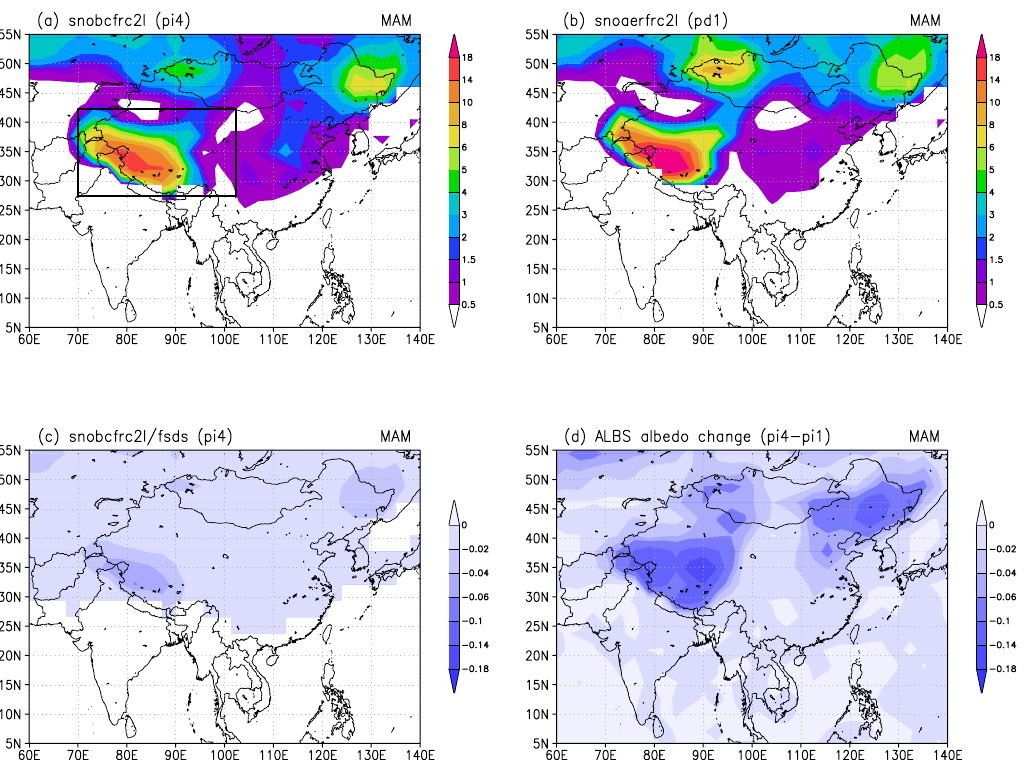
Fig. 6. Spatial distribution of surface forcing (a) induced by BC only in snow in pi4 (unit: Wm − 2 ) , (b) induced by BC+Dust in snow in pd1 (unit: W m − 2 ) , (c) snow albedo change induced by the presence of BC in snow only (i.e. snobcfrc2l/fsds) in pi4, averaged only when snow is present, and (d) broadband surface albedo change in pi4, which is caused by changes of snow fraction/depth and BC in snow. All are averages for MAM.